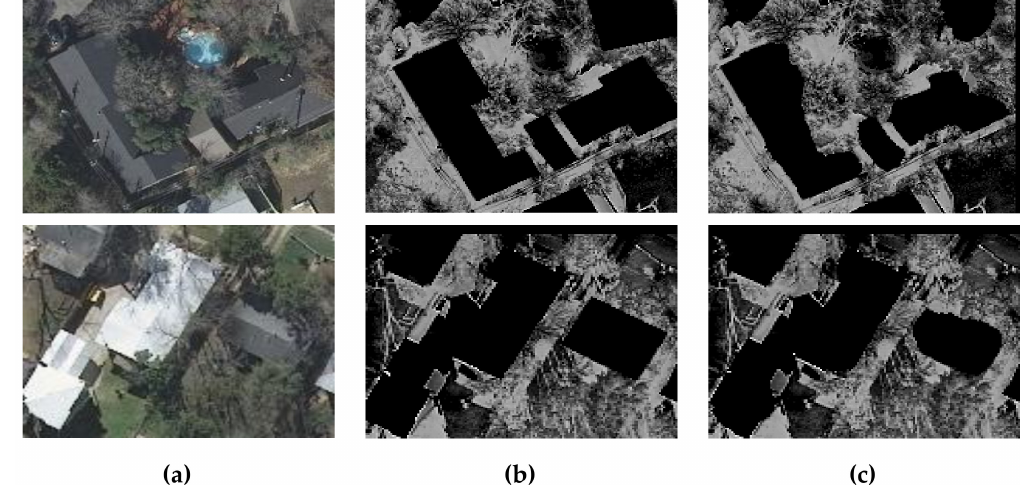
Figure 4. Fusion features of input images (one channel) and the predicted label maps / ground truths. ( a ) Input images; ( b ) Fusion results of input images and ground truths; ( c ) Fusion results of input images and the predicted label maps (5000